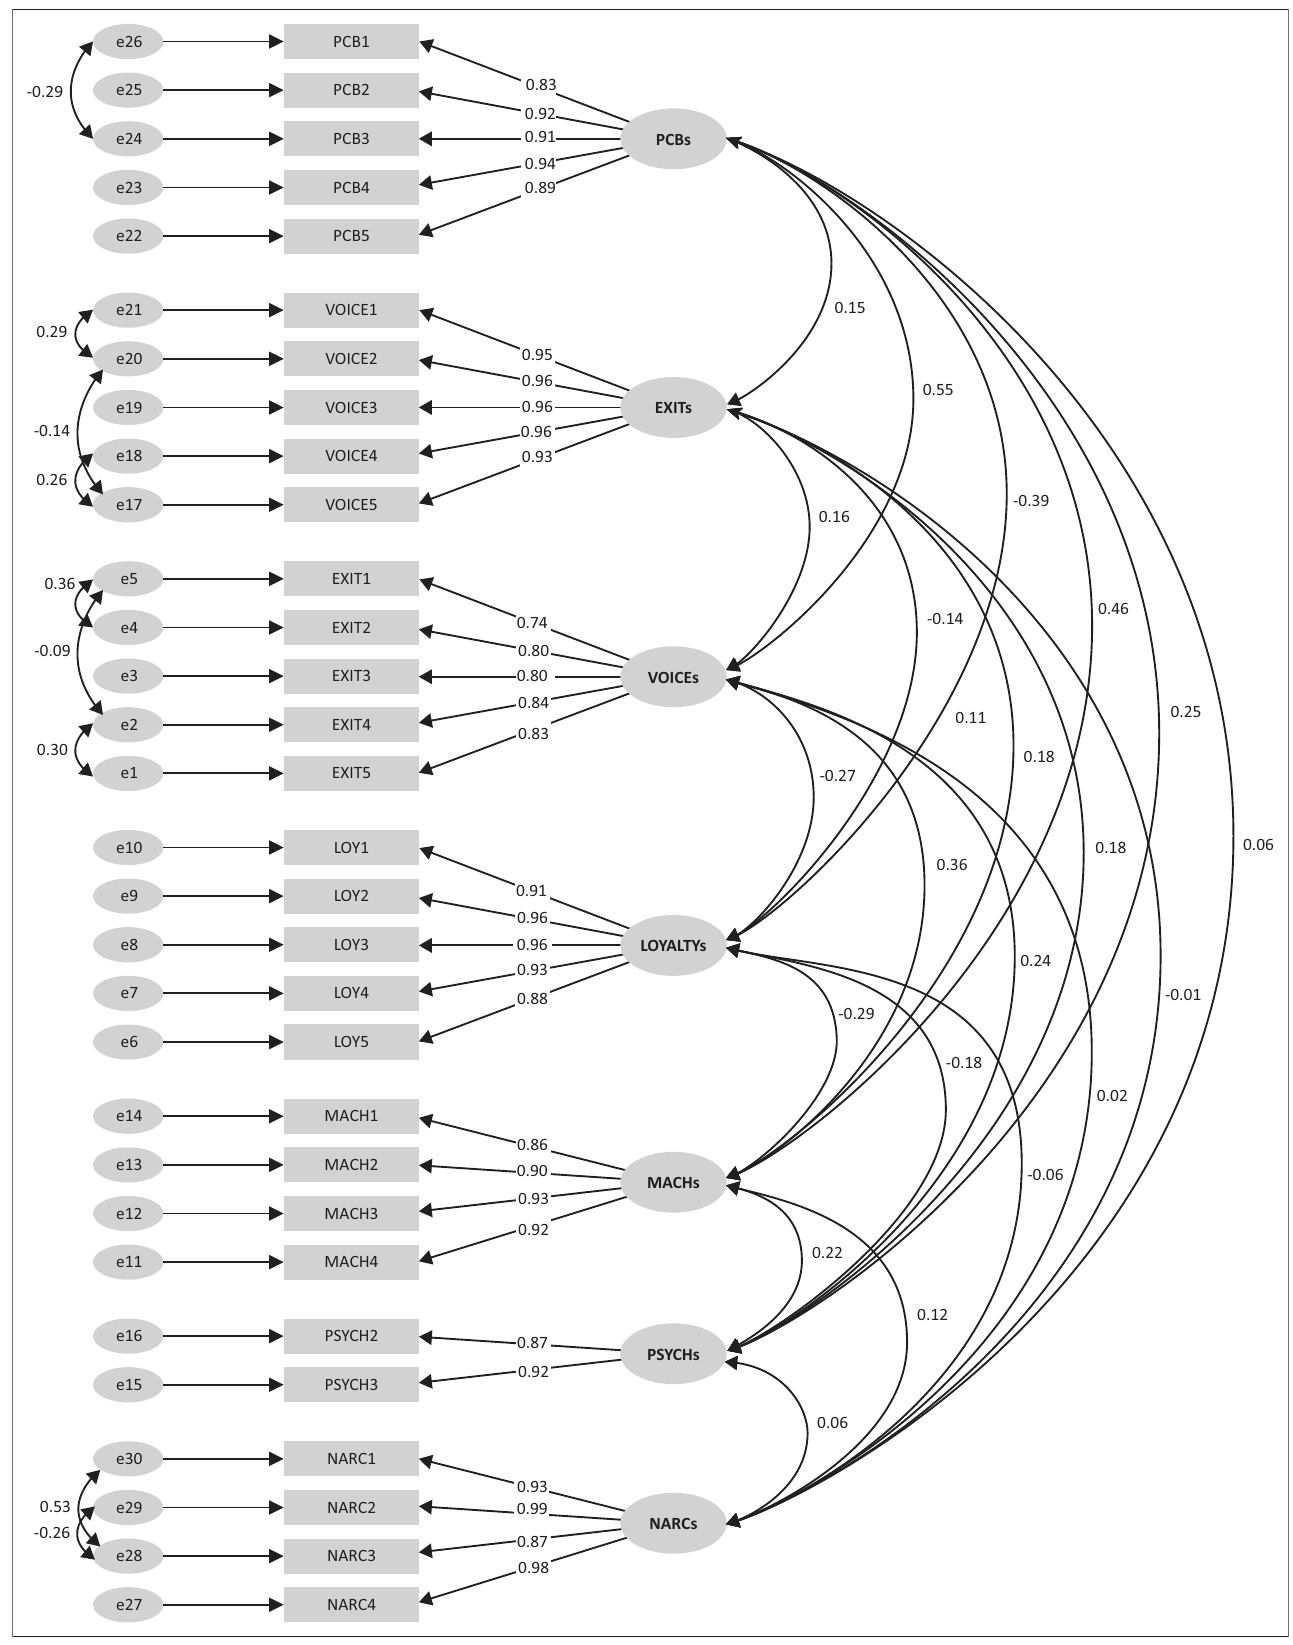
FIGURE 1: Confirmatory factor